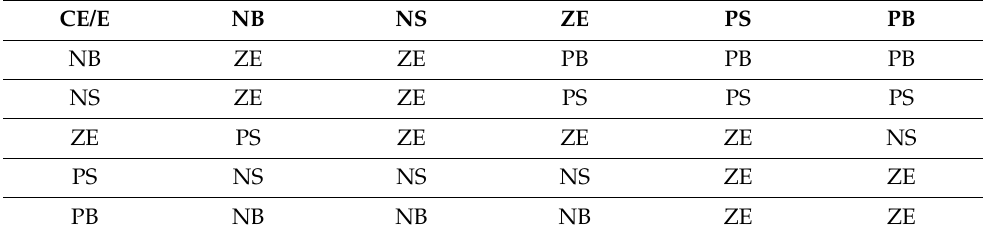
Table 1. FLC rule base